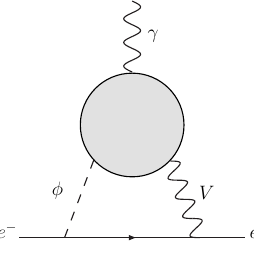
Figure 3. Two-loop Barr–Zee diagrams [42] contributing to the electron EDM, where φ denotes neutral and charged Higgs bosons, and V denotes vector bosons γ , Z and W